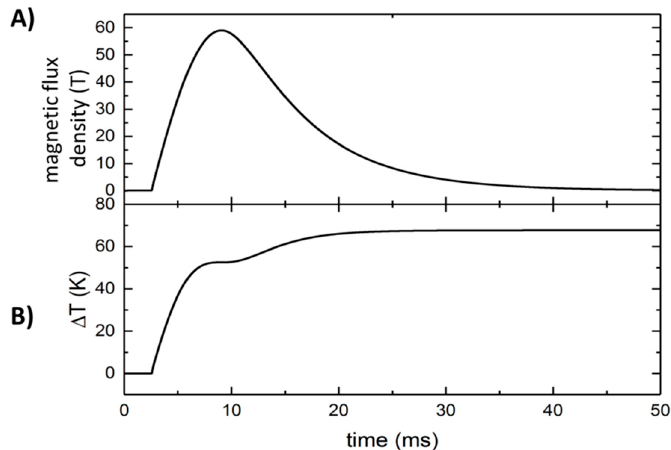
Figure 8. ( A ) Temporal magnetic-flux profile of the field pulse. ( B ) Heating of the Ag loop (50 nm thickness) with bulk metal properties caused by IH.